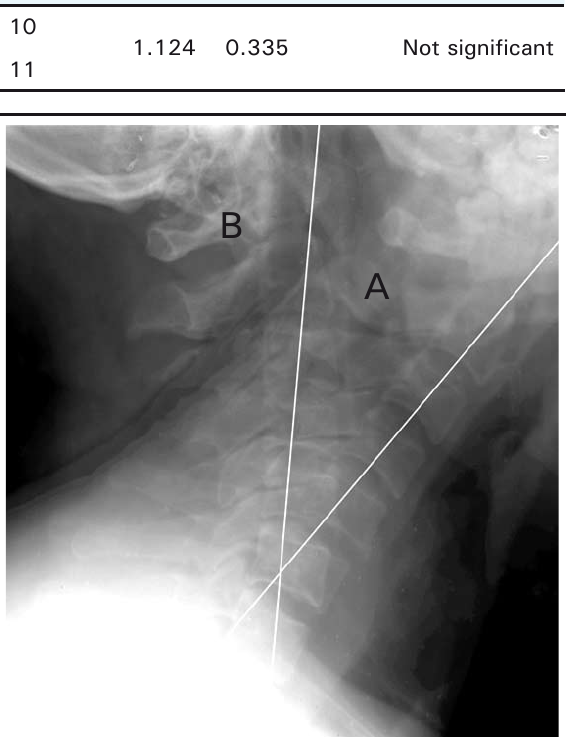
Figure 1. Superimposed lateral radiographs with (A) and without Namlo (b). the difference of axes